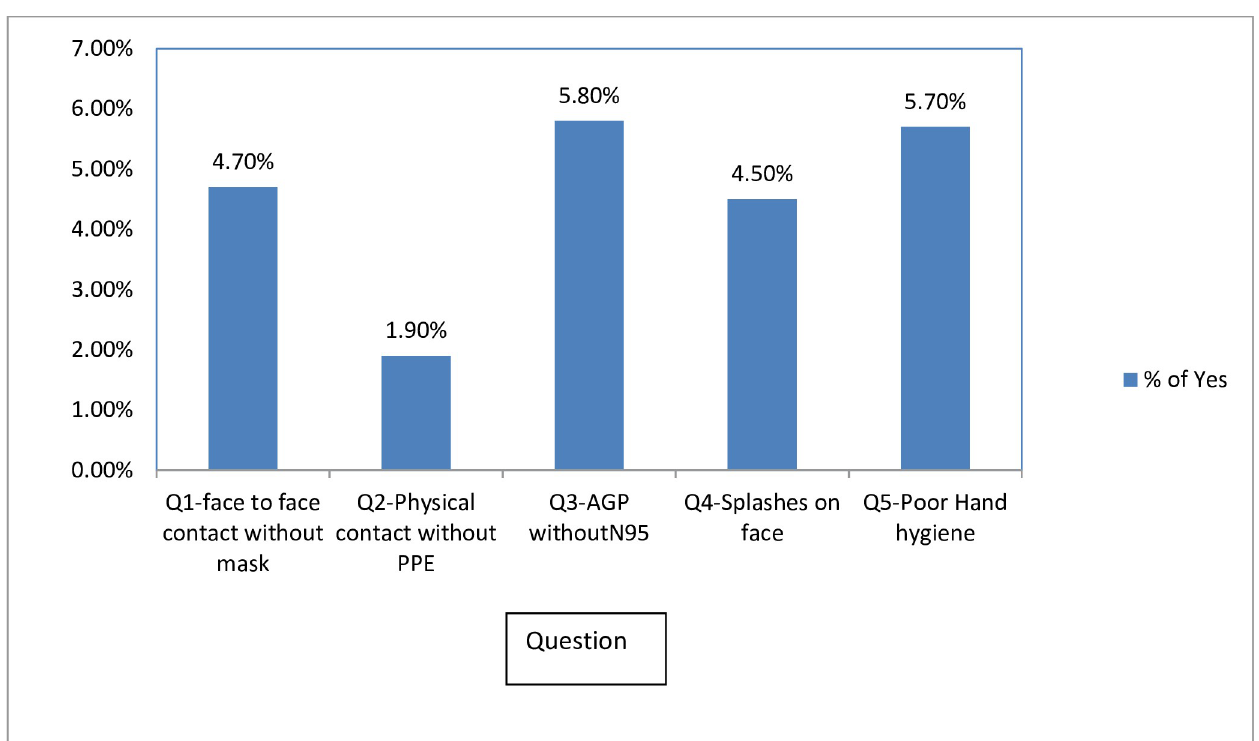
Fig 2. Rate of “yes” responses for each question in the assessment